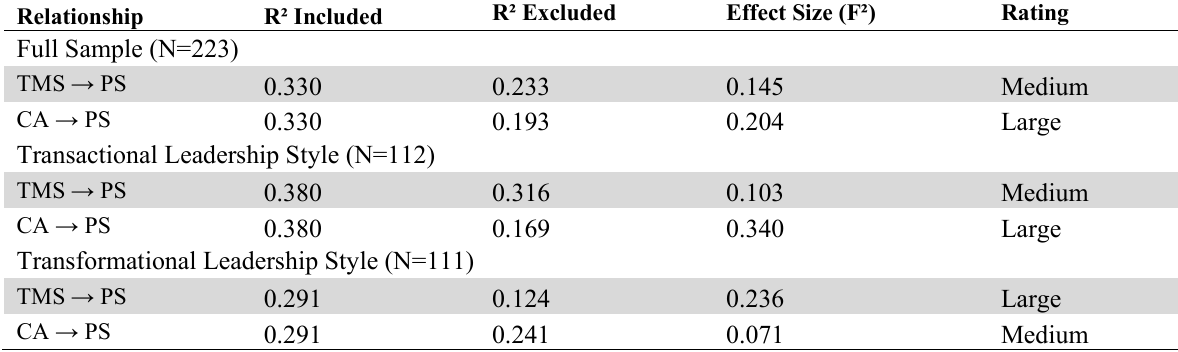
Effect size of the relationship between CSFs and project success Relationship